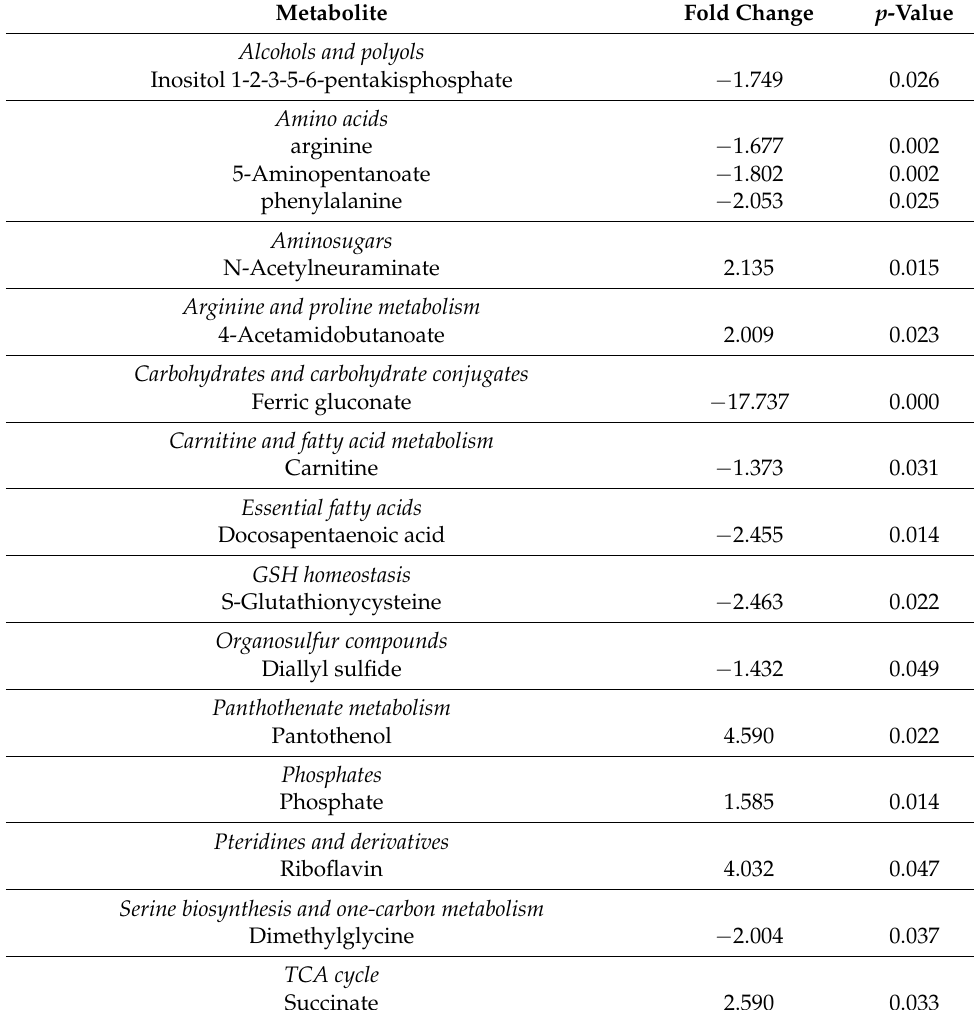
Table 2. List of all differentially expressed metabolites in BVNF versus SVNF sera, classified by each implicated